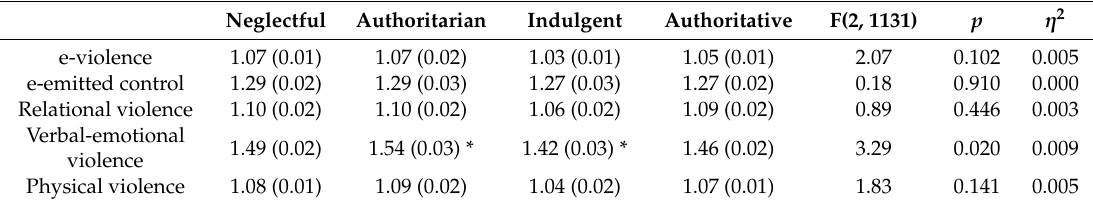
Table 7. Means, standard deviations (in brackets), F values, p values, e ff ect size, and post hoc